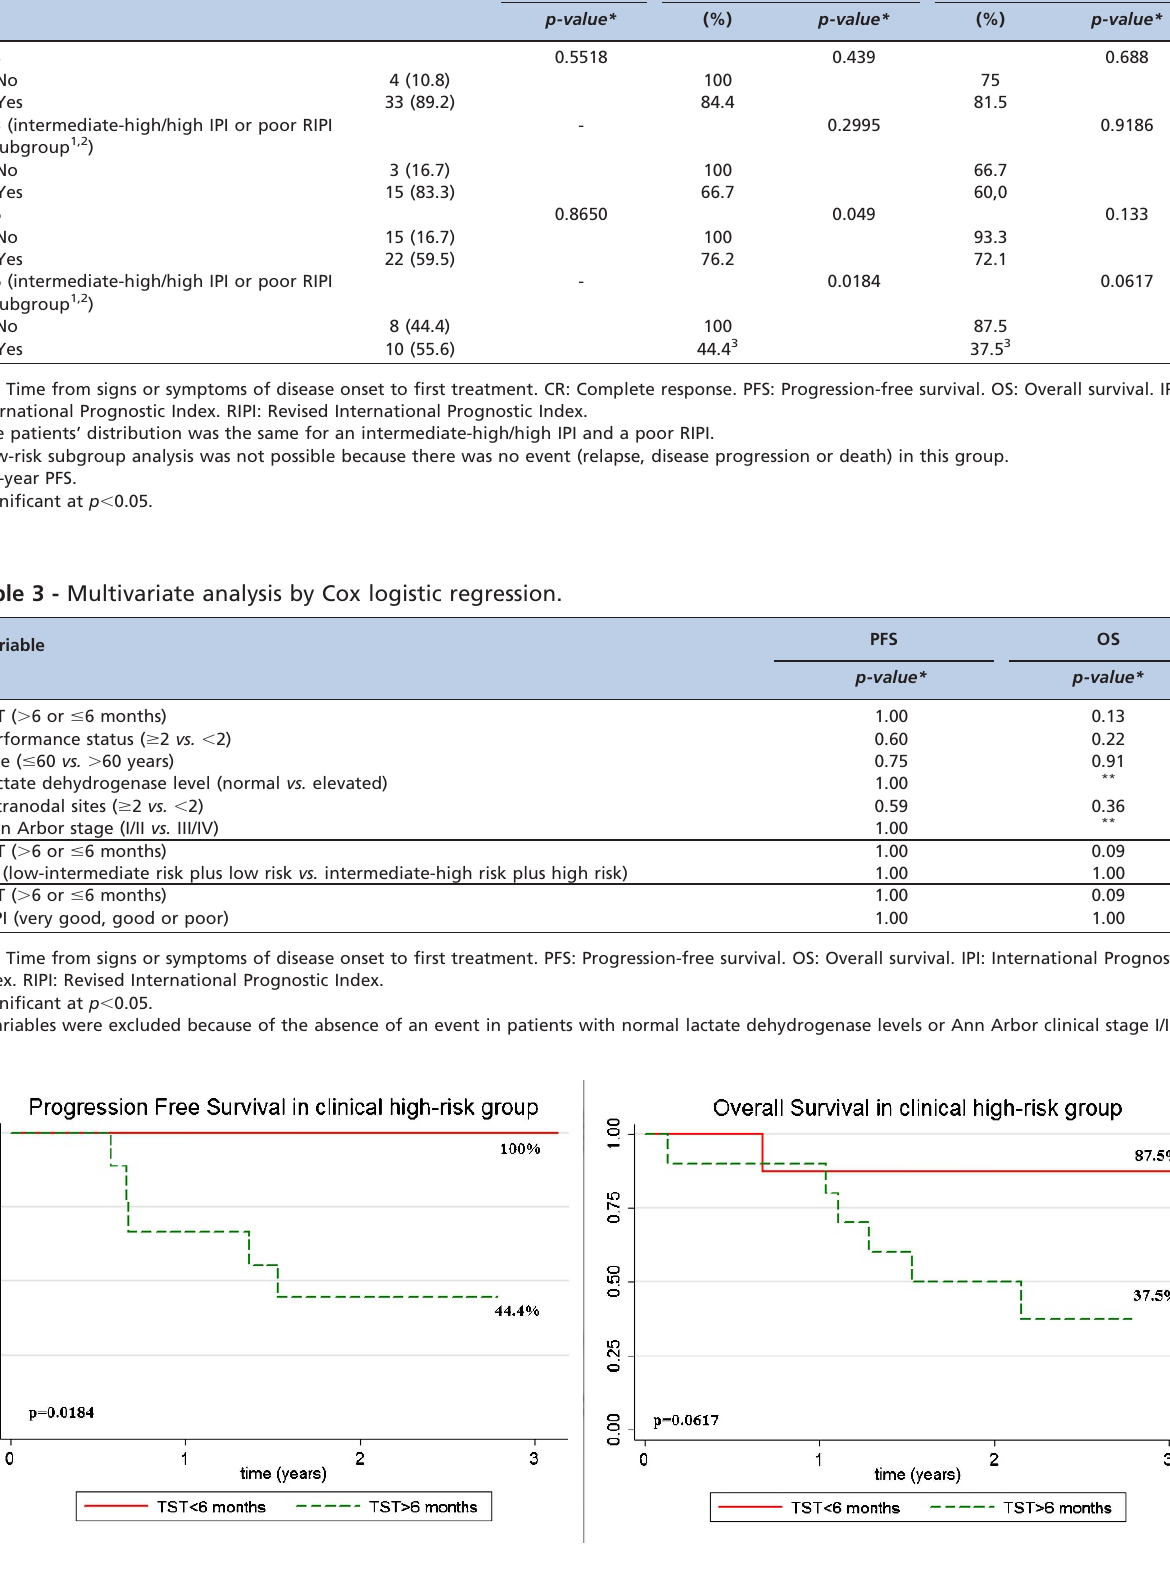
Figure 3 - Progression-free survival and overall survival in high-risk groups (an intermediate-high/high risk IPI or a poor